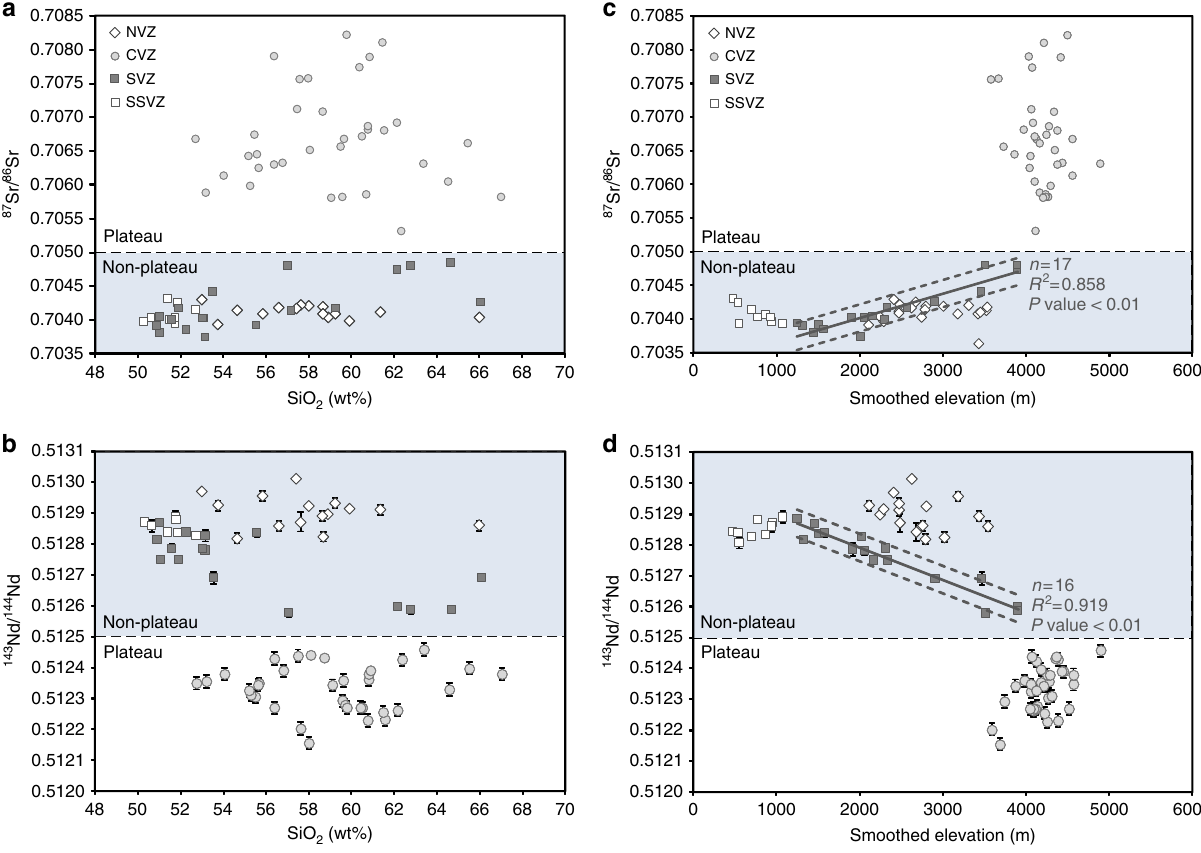
Fig. 4 Baseline Sr and Nd isotopes as a plateau discriminant and palaeoelevation proxy. a , b Baseline isotopic compositions within each volcanic zone vary little with differentiation from basaltic andesite to rhyolite 46 ; even the least silicic CVZ rocks are enriched in 87 Sr/ 86 Sr (>0.7050) and depleted in 143 Nd/ 144 Nd (<0.5125). c , d Baseline isotope compositions compared to smoothed elevation. Elevation smoothed to a radius of 37.5km was calculated from the Shuttle Radar Topography Mission DEM (SRTM1, pixel resolution 90 m 71 ). A radius of 37.5km is selected as this is half of the maximum crustal thickness in the Andes. Smoothing to this degree fi lters out non-isostatic, short wave-length topography. 95% con fi dence intervals are represented as dashed lines (excluding samples south of 38.5°S, see text). Volcano locations are shown on Fig. 1a. Symbols are bigger than the maximum analytical error isotope on isotope data, except where shown. Typical quoted analytical precision on SiO 2 compositions are ~3% RSD. All data shown here are presented in Supplementary Data